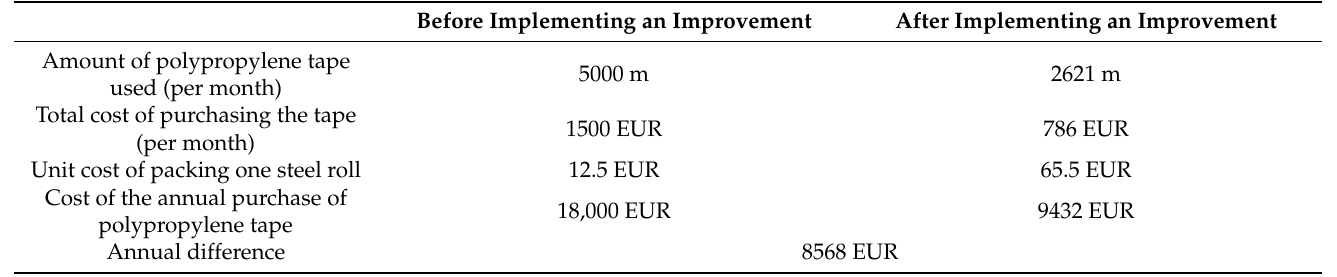
Table 4. Situation before and after the implementation of the improvement.